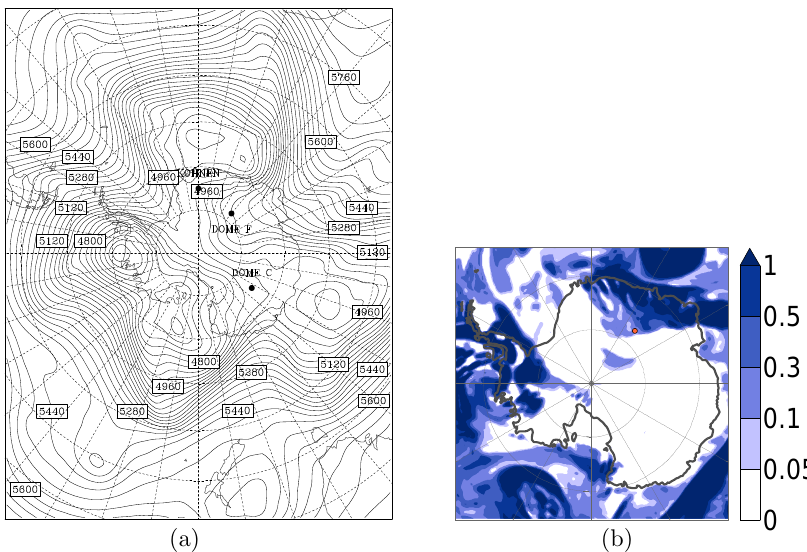
Figure 5. Example of an amplified high-pressure ridge: (a) 500hPa geopotential height from AMPS, 1 August 2003 12:00UTC, (b) 6h precipitation in mm from AMPS, 1 August 2003 06:00UTC.